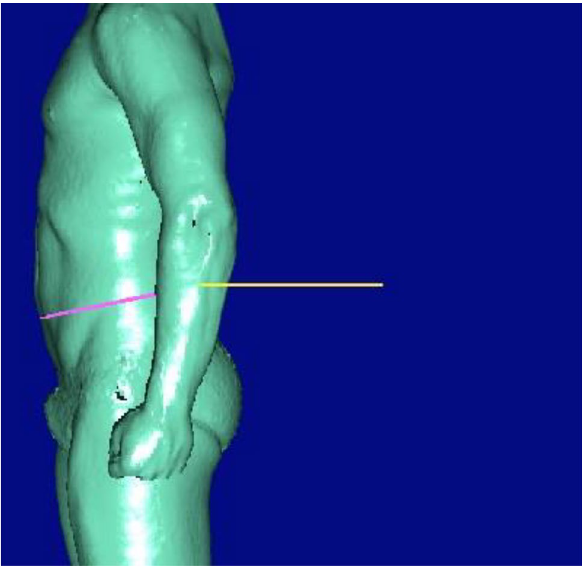
Figure 3. “Distance back to the wall” as unsuitable parameter for daily practice. This image was provided with kind permission of the